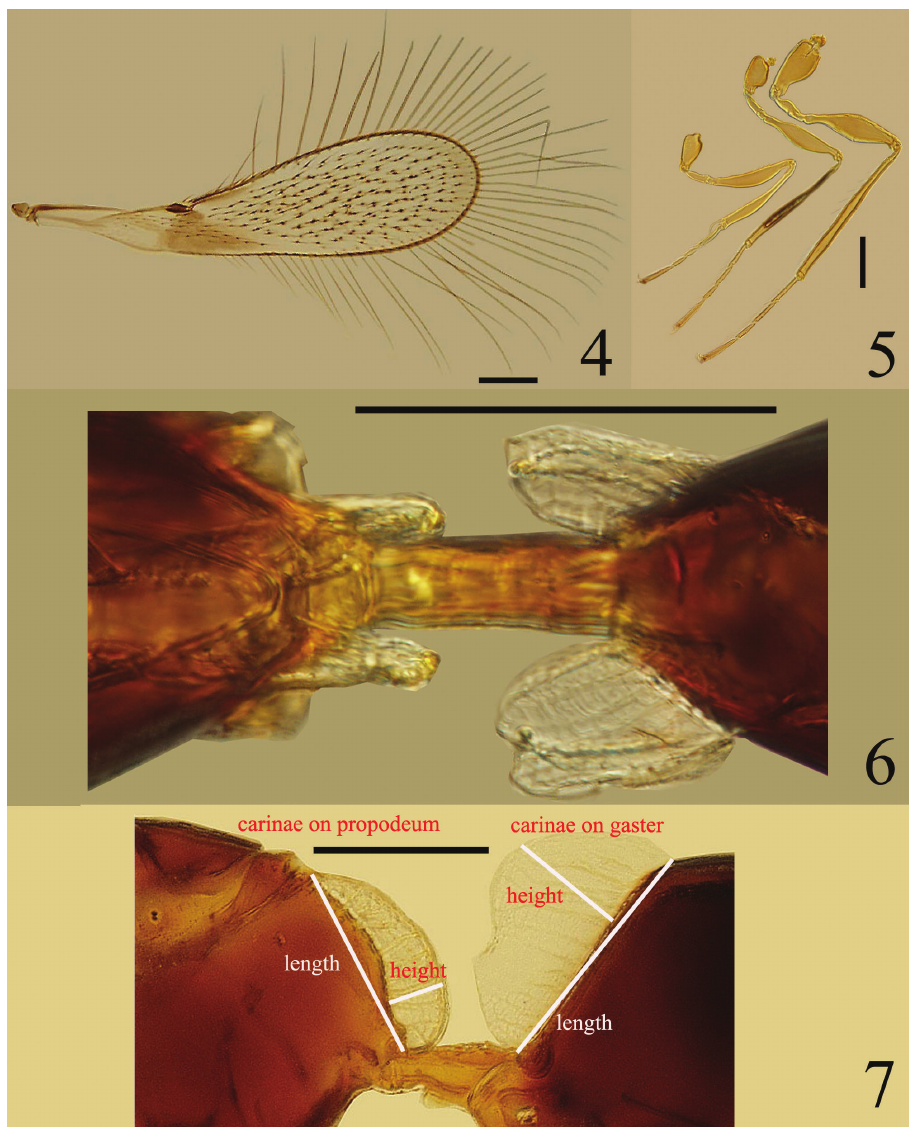
Figures 4–7. Ptilomymar dianensis sp. n., holotype female: 4 fore wing 5 legs 6 carinae on mesosoma and metasoma, dorsal 7 carinae on mesosoma and metasoma, lateral. Scale bars=100 pronotum and petiole brown. Fore wing hyaline, with a triangular dark brown mark- ing behind marginal vein, and a narrow brown strip just beyond venation. Venation brown with stigmal vein dark brown. Legs yellowish-brown with last tarsal segments brown. Metasoma dark brown with ovipositor brown. Head. Eye about 1.5× as long as wide; facets large, each nearly the size of an ocellus. Vertex 0.82× as long as wide, with strong reticulate sculpture; POL about 6.5× as long